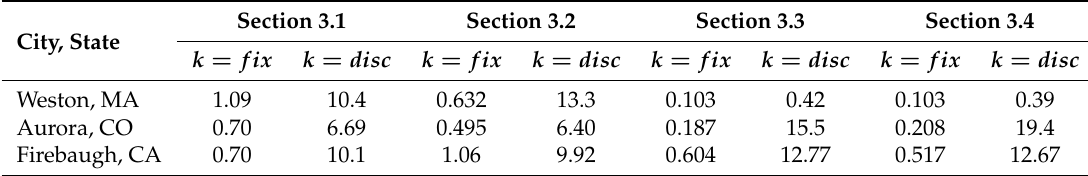
Table 5. The solution times (in seconds) for each of the numerical